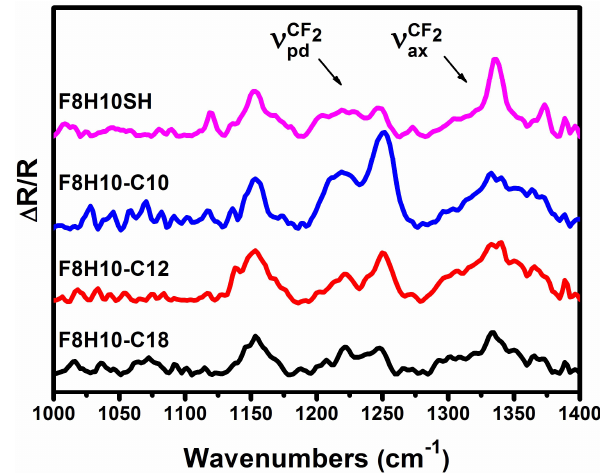
Figure 6. PM-IRRAS spectra of the C-F stretching region for SAMs generated from the F8H10SH and F8H10-Cm adsorbates used in the study.